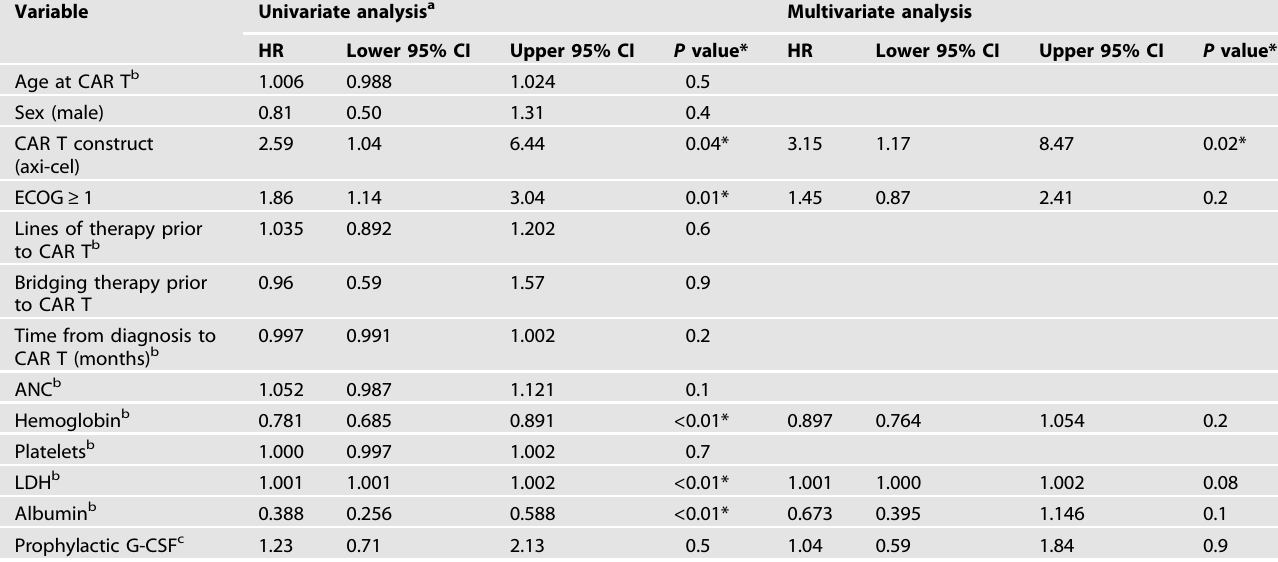
Table 5. Cox proportional hazards model for Grade ≥ 2 ICANS in lymphoma cohort. Variable Univariate analysis